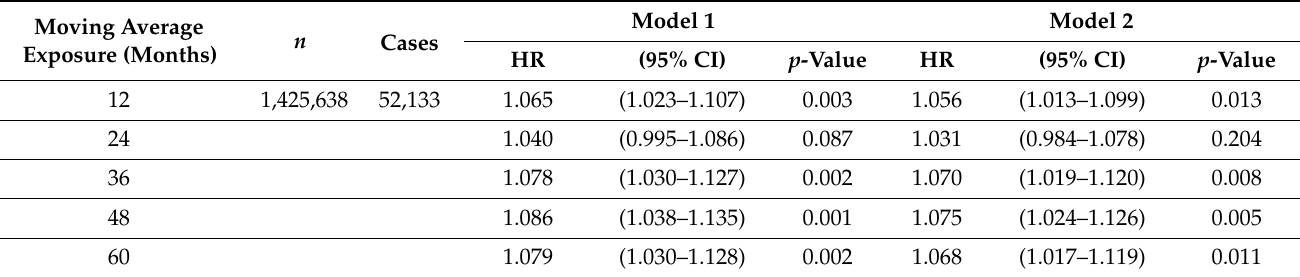
Table 2. Hazard ratios for asthma incidence per 10 µ g/m 3 increase in PM 2.5 levels.